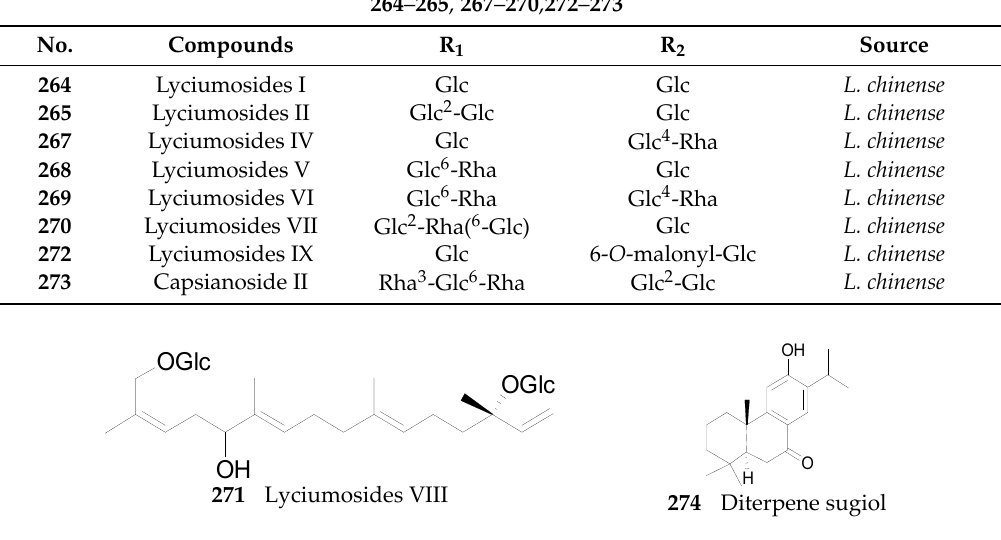
Figure 20. Chemical structures of compounds 271 and 274 . Table 12. Chemical structures of compounds 275 – 282 .